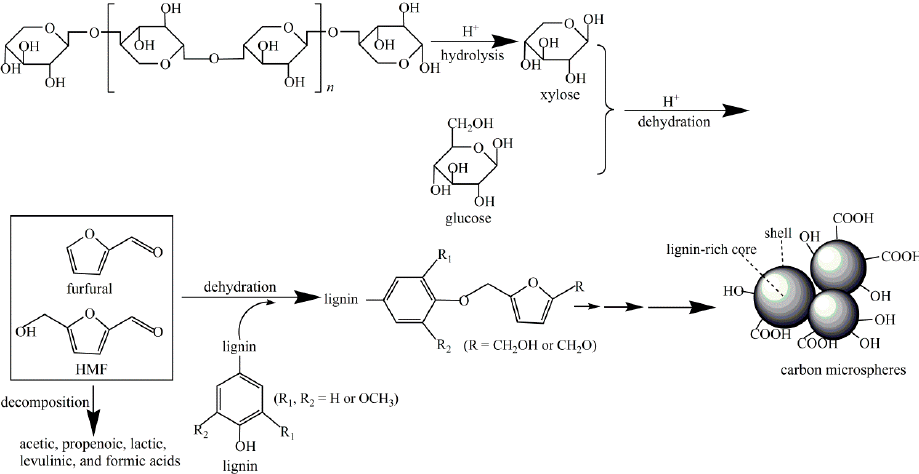
Figure 3. The preparation mechanism of CM-PHL. Reprinted with permission from Ref. [23]. Cop- yright 2019 Elsevier.